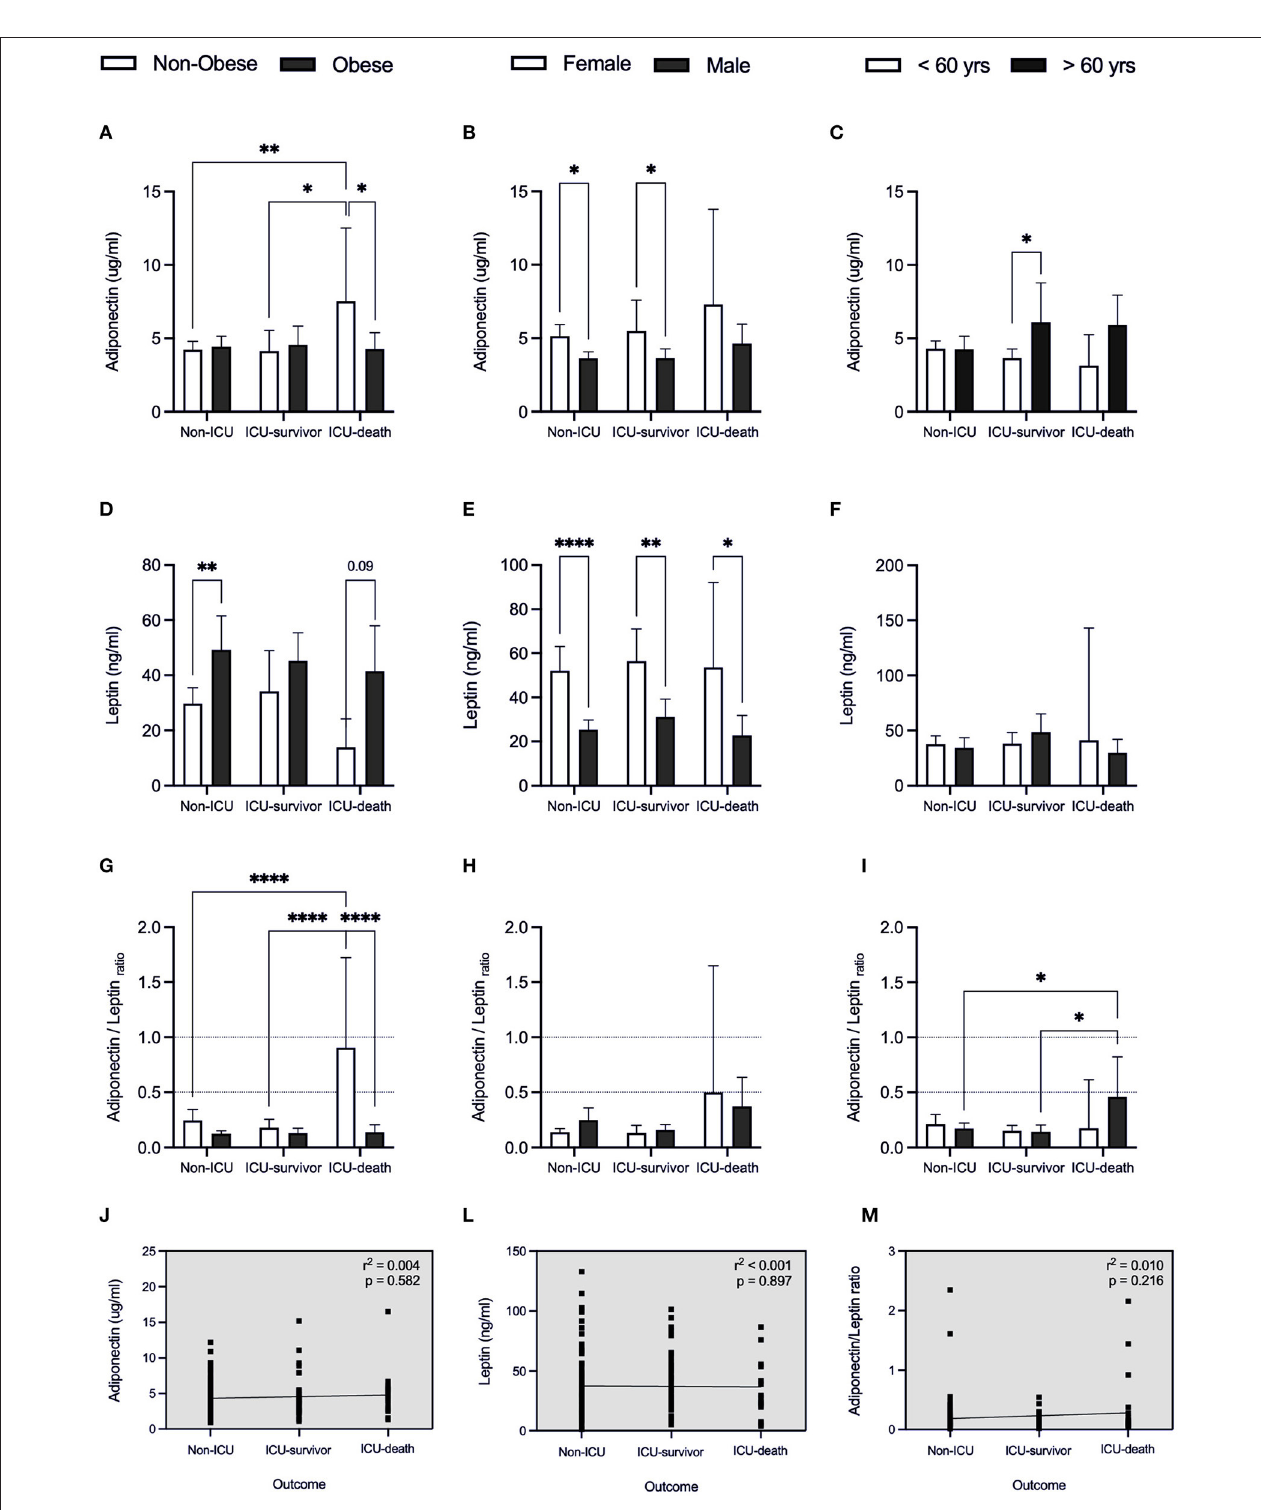
FIGURE 4 | Adipose-derived hormones for patients with COVID-19 in relation to clinical outcome. Values expressed as mean with 95% Confidence Interval for patients that were hospitalized without intensive care (Non-ICU), patients admitted to the intensive care unit and discharged (ICU-survivor) and patients who died (ICU-death), including: adiponectin (A–C) , leptin (D–F) , and adiponectin/leptin ratio (G–I) related to body index mass (BMI), sex and age, respectively. Dashed box presents linear regression curve of adiponectin (J) , leptin (L) , and adiponectin/leptin ratio (M) as dependent variable (Y axis) with outcome as independent variable (X axis). Significance: * p < 0.05; ** p < 0.01; **** p < 0.0001.